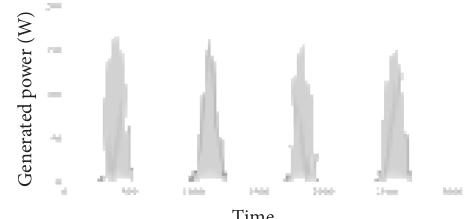
Figure 26: Generated power at the node.